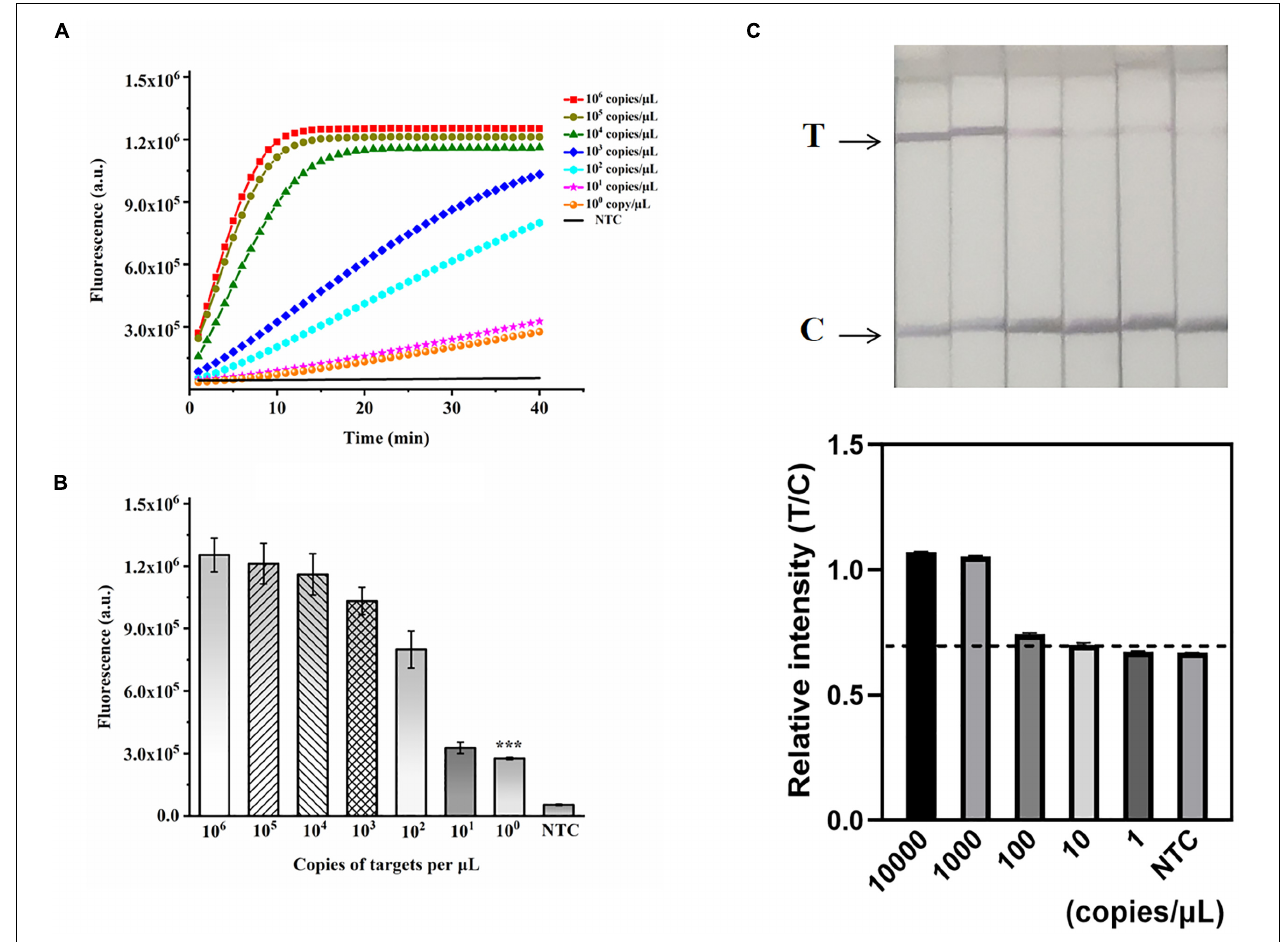
FIGURE 5 | Validation of the sensitivity of the ERA/CRISPR–Cas12a dual system. (A) Fluorescence curves generated by the ERA/CRISPR–Cas12a fluorescence system at each dilution. (B) Comparison of fluorescence values generated after 40 min of ERA/CRISPR–Cas12a fluorescence system reaction at each dilution. *** p <0.001. (C) Analytical sensitivity of the ERA/CRISPR–Cas12a dipstick system at each dilution. The black horizontal dashed line in the gray scan indicates the cutoff value set based on T/C values of the negative control. Error bars in panels represent the mean ± SD, where n = 3